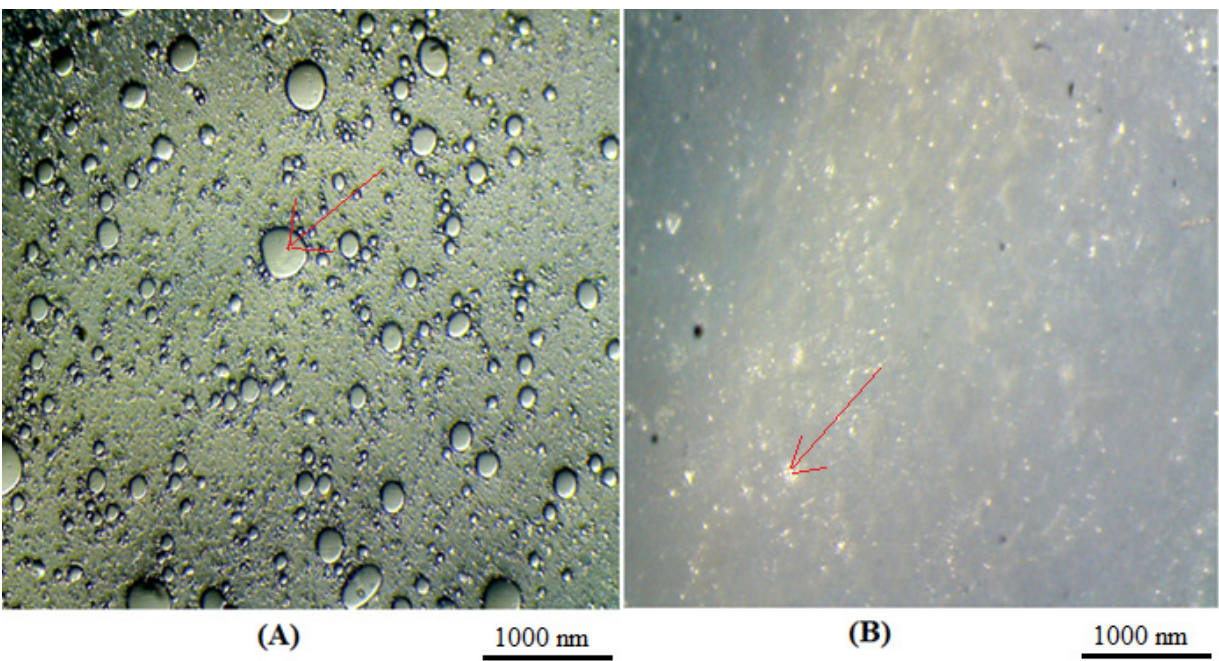
Figure 3. Microscopic view of ( A ) P. granatum ethosome suspension and ( B ) P. granatum ethosome gel. Arrows show the representation of the respective ethosome suspension and ethosome gel.